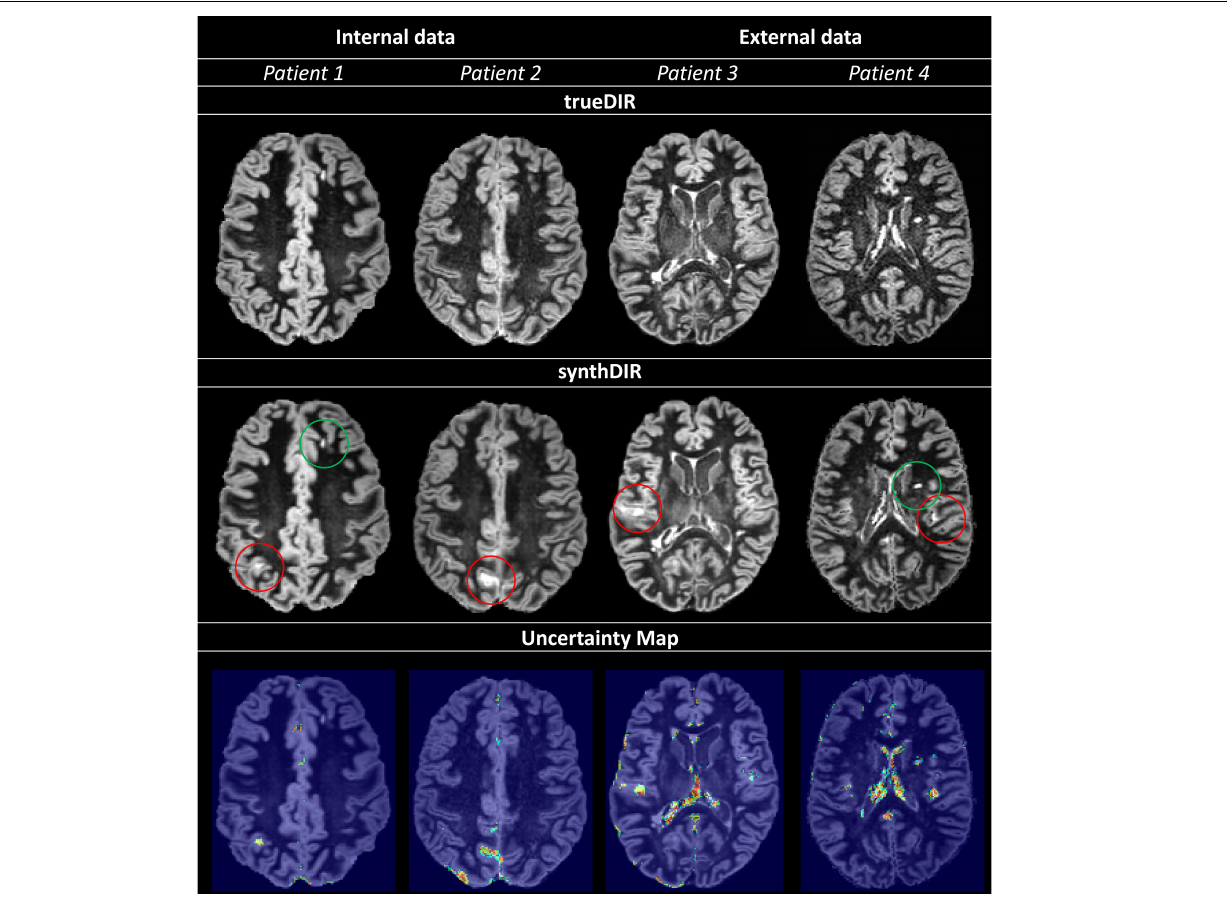
FIGURE 3 | Uncertainty maps provide relevant information regarding the validity of voxel-to-voxel translation; increases in uncertainty are scaled from blue to green. Circled in red (Patients 1–4) are hyperintensities in synthDIR without correlation in trueDIR and easily recognized as areas of high variance in the corresponding uncertainty maps, allowing for their identification as artifacts from the synthesis task. On the other hand, true-positive lesions are readily identified as regions with either no (patient 1 – green circle in synthDIR) or low (patient 4 – green circle in synthDIR) values of uncertainty. Hence, interpretation of synthDIR and decision-making on the veracity of lesions is facilitated through uncertainty